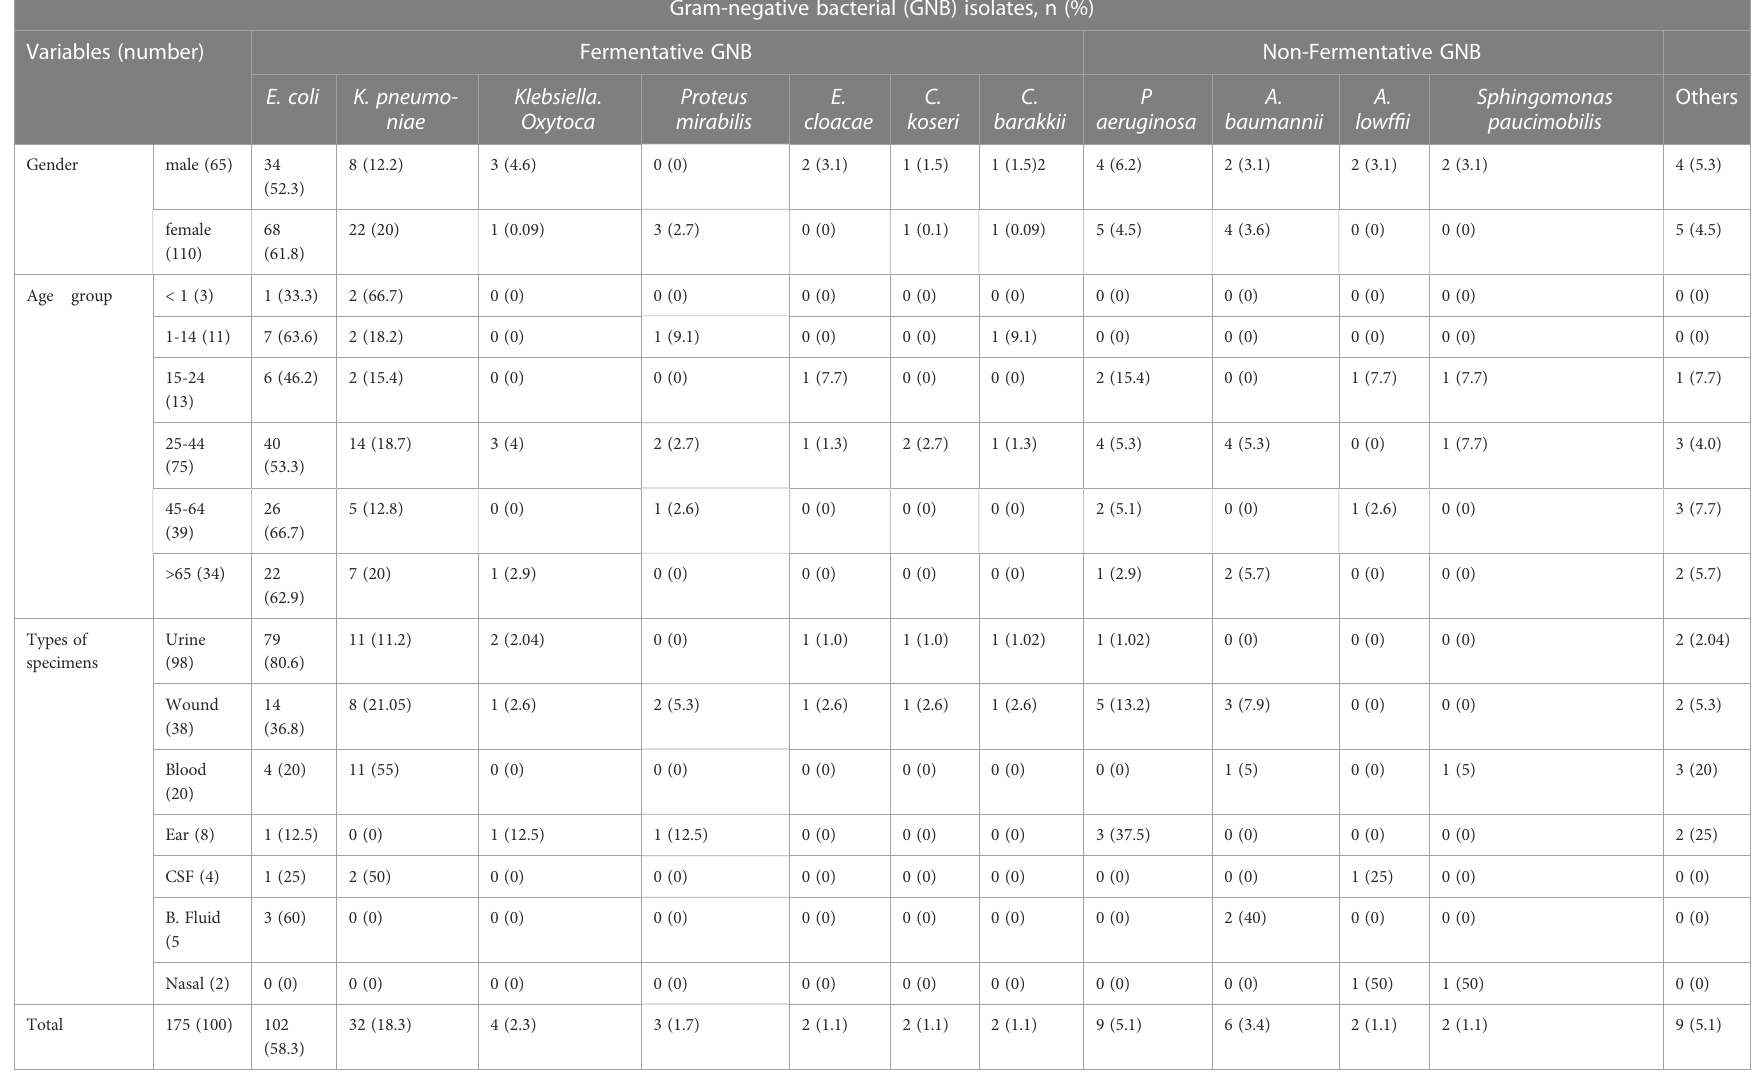
TABLE 2 Distribution of bacterial isolates according to sex, gender type of